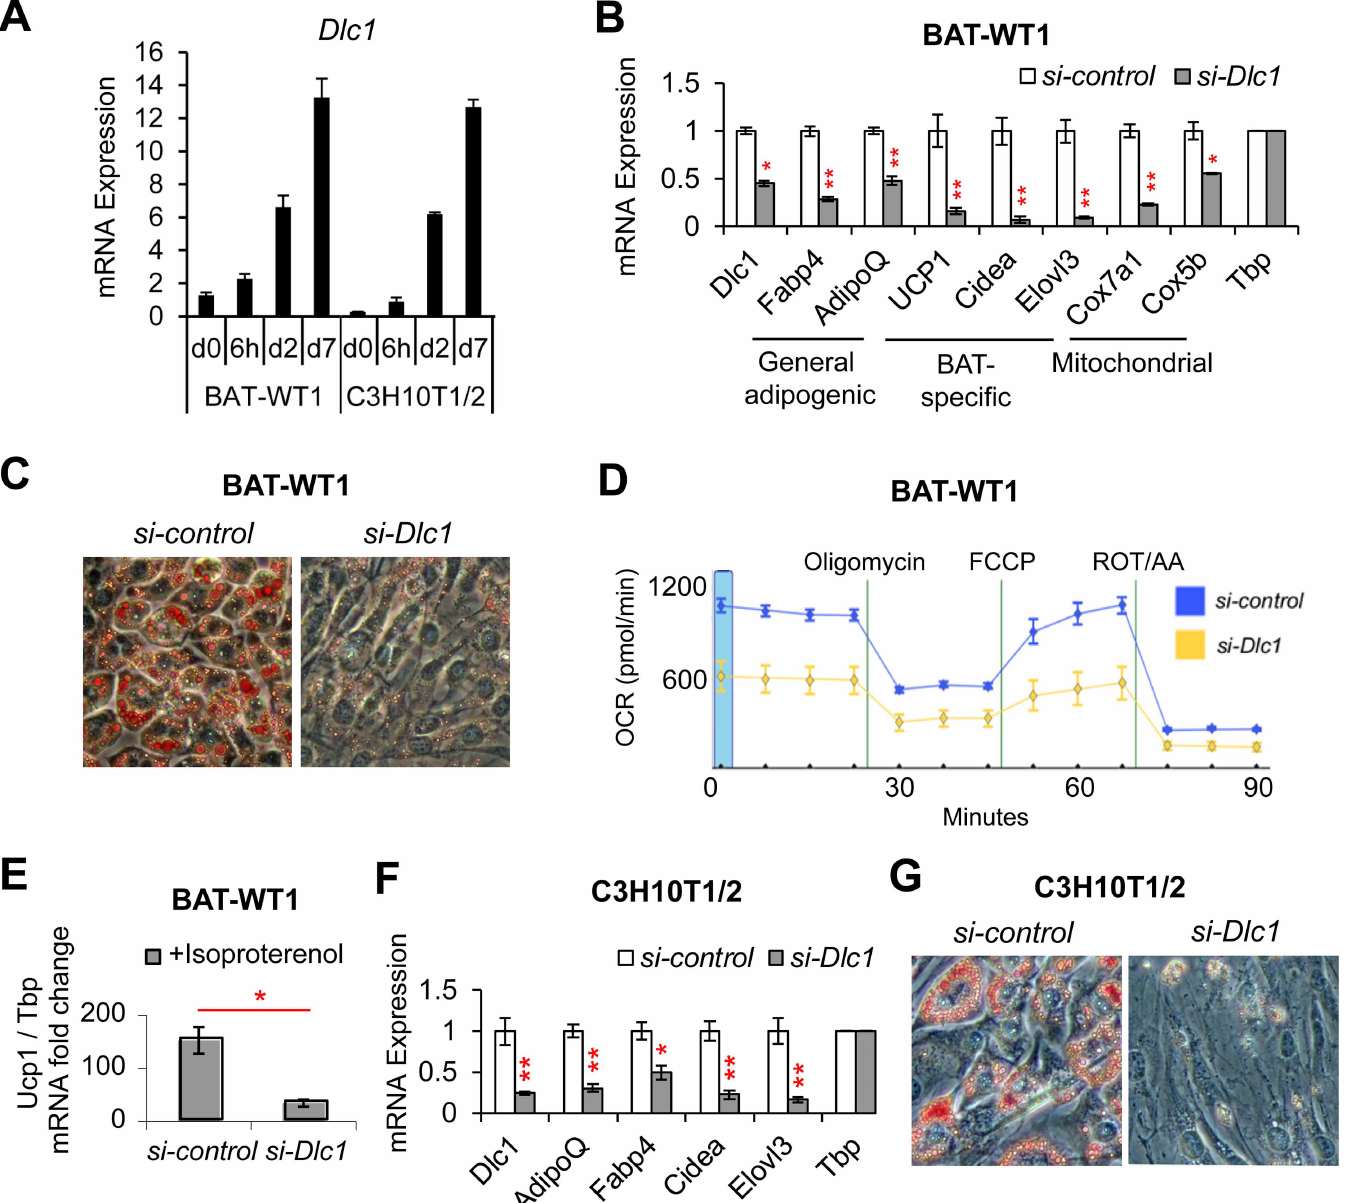
Fig 3. DLC1 Regulates Brown Adipogenesis and Brown Cell Function. (A) mRNA expressionof Dlc1 gene duringdifferentiationof BAT-WT1 brown adipocytesand C3H10T1/2 derived brown adipocytes. (B) mRNA expressionof Dlc1 , generaladipogenic, BAT-specific and mitochondrial genes in BAT-WT1 brown adipocytesupon Dlc1 knockdown. (C) Oil-Red-O stainingshowingreducedlipid droplet formation in Dlc1 knockdown BAT-WT1 brown adipocytes. (D) Oxygen consumptionrates (OCR) in BAT-WT1 brown adipocyteswith or without Dlc1 knockdown. Vertical green lines indicate the time points of Oligomycin, FCCP and Rotenone/Antimycin A (ROT/AA) injection. n = 3. (E) qRT-PCR measurements of the fold changeof Ucp1 expressionafter isoproterenol treatment comparedwith basal levels without treatment. Dlc1 knockdown significantly impaired the upregulation of Ucp1 expressionafter isoproterenol treatment. (F) mRNA expressionof Dlc1 , general adipogenic and BAT-specific genesin Dlc1 knockdown brown adipocytesderivedfrom C3H10T1/2cells. (G) Oil-Red-O stainingshowingreducedlipid droplet formation in Dlc1 knockdownbrown adipocytesderivedfrom C3H10T1/2 cells. Data are presented as mean ± s.e.m. n = 3–6 biological replicates.Two-tailed Student’s t -test was used: * P < 0.05, ** P < 0.01.